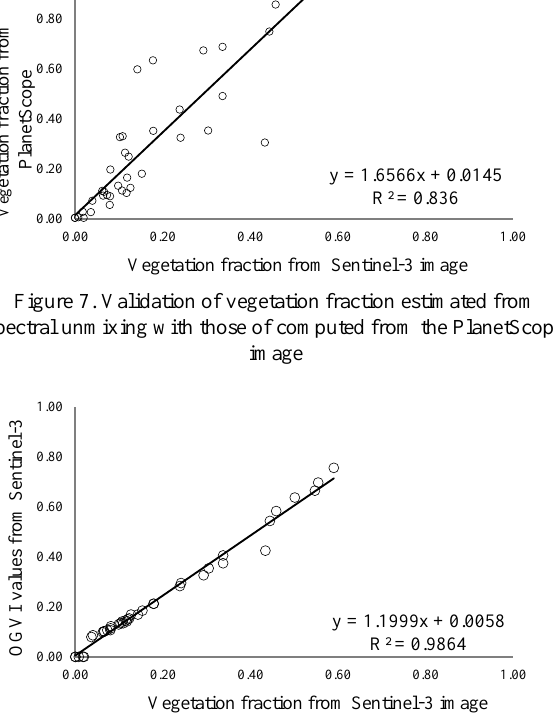
Figure 8. Vegetation fraction estimated from spectral unmixing compared with values from OGVI product of Sentinel-3